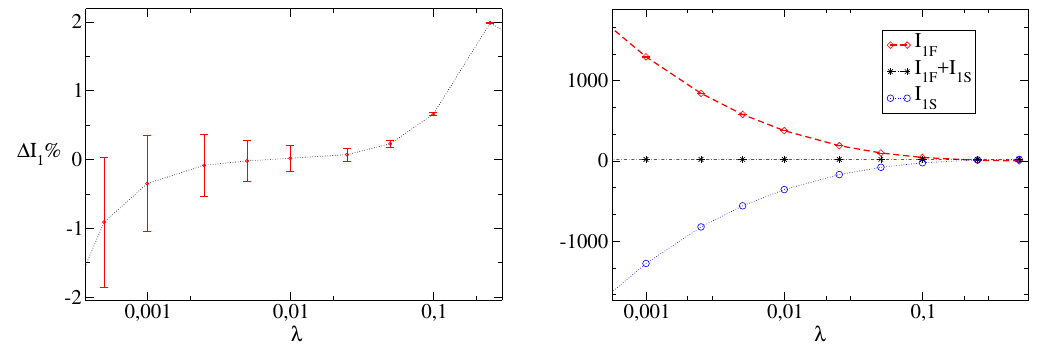
Figure 7 . This (cid:12)gure shows (cid:1) I 1 ( (cid:21) ) on the left and also separately the (cid:15) 0 coe(cid:14)cients of I 1 F ; I 1 S and their sum on the right in the subtraction method. In both (cid:12)gures I 1 F is evaluated numerically using 10 8 points for each value of (cid:21)